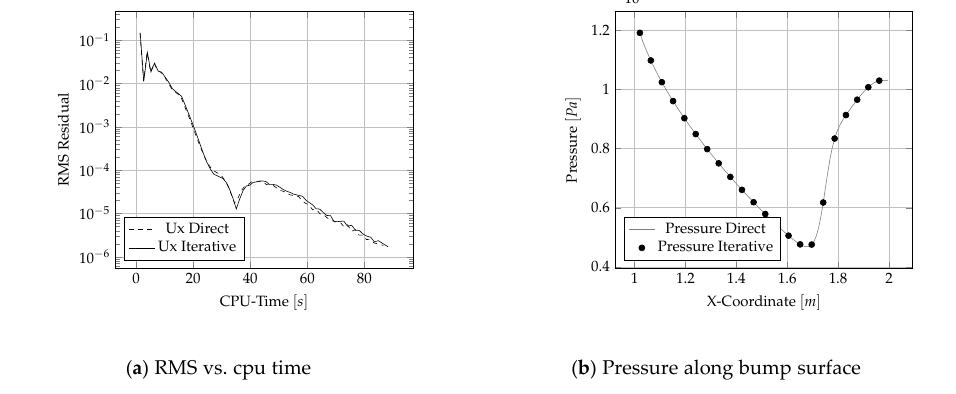
Figure 5. Consistency results on transonic bump.